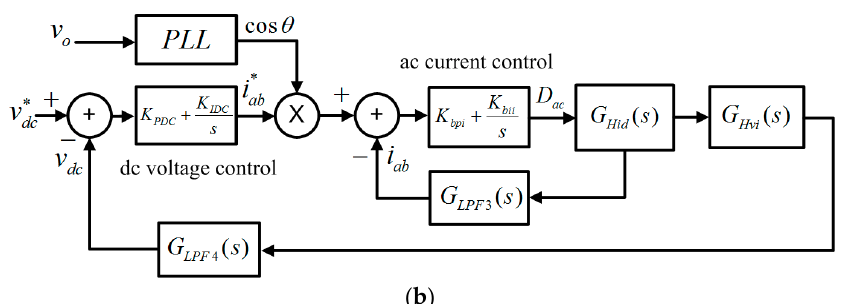
Figure 10 . Control block diagram for the microinverter. ( a ) dc-dc converter; ( b ) dc-ac converter.